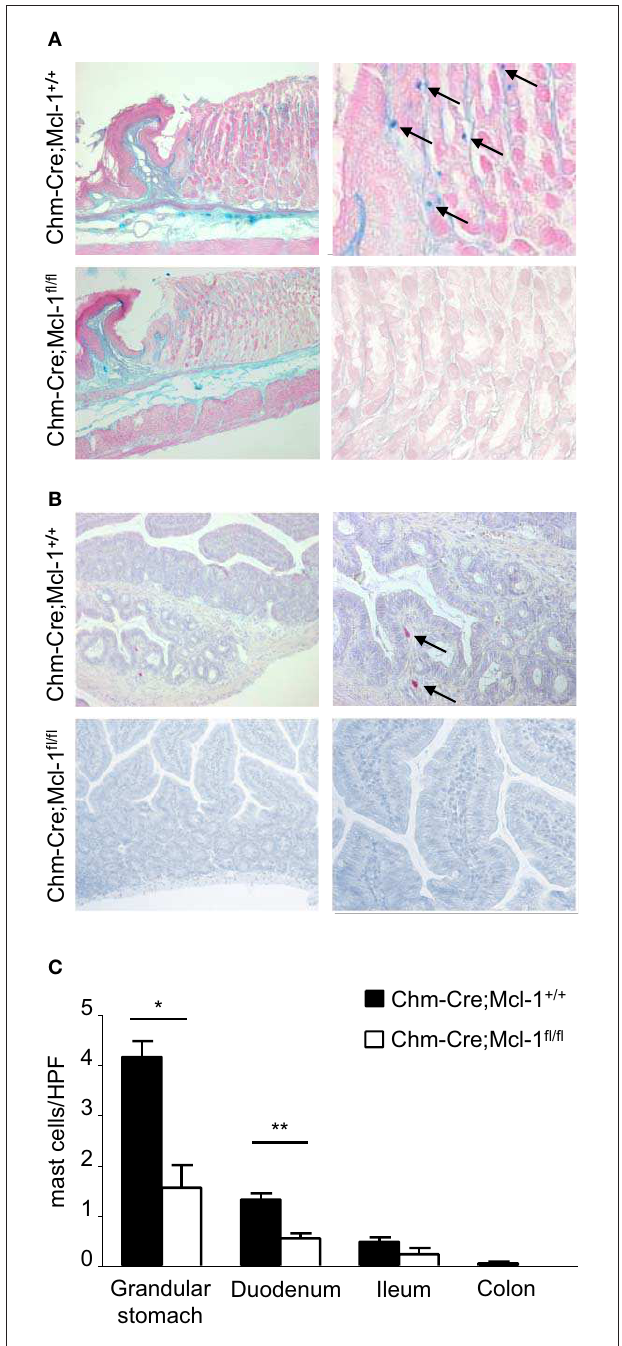
FIGURE 1 | Chm-Cre; Mcl-1 fl / fl mice have markedly reduced numbers of representative mucosal mast cell (MMC) populations. (A) Alcian blue staining for stomach MCs of 5- µ m-thick paraffin sections showed markedly reduced MCs numbers (blue) in Chm-Cre; Mcl-1fl/fl mice compared to control Chm-Cre; Mcl-1 + / + mice. (B) Chloroacetate esterase staining for intestinal MCs showed decreased number of MCs (red) in duodenum of Chm-Cre; Mcl-1 fl / fl mice compared to control Chm-Cre; Mcl-1 + / + mice. (C) Numbers of MCs in different gastrointestinal tissues were assessed by quantitative histomorphometry analysis. (A,B) left: 100 × magnification, (A) right: 400 × magnification, (B) right: 200 × magnification. Data were pooled from three independent experiments ( n = 5 mice per group) and expressed as mean ± SEM (* P < 0.05, ** P < 0.01, n.s., not